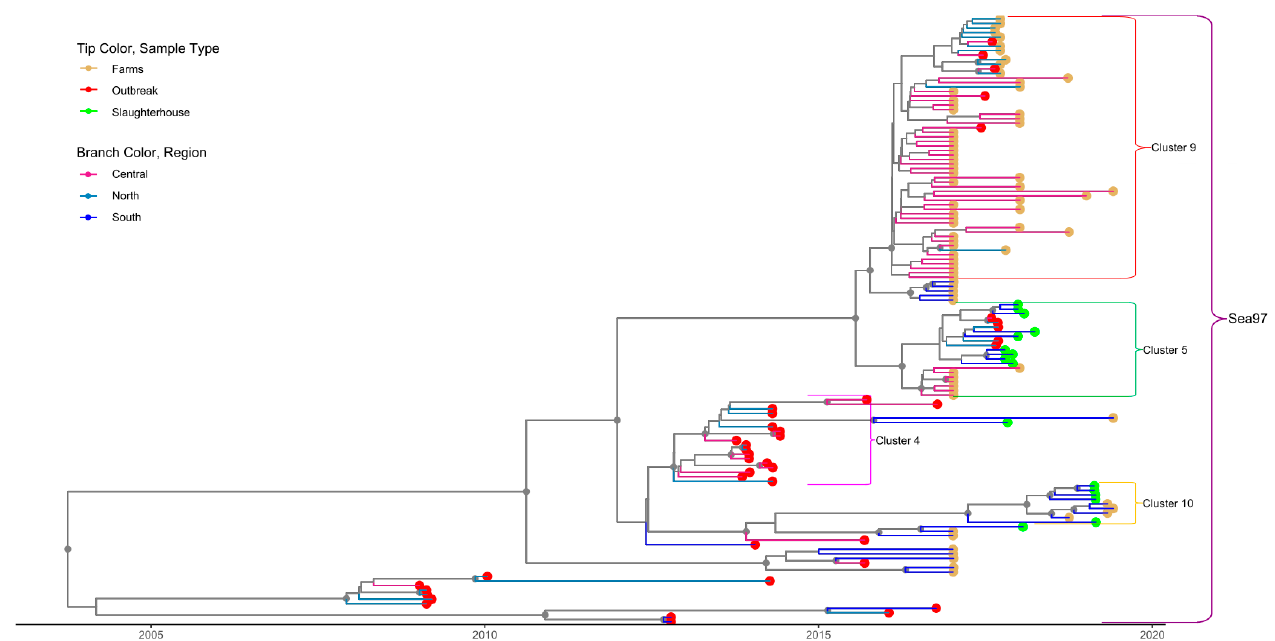
Figure 4. Time-scaled phylogeny for serotype A sequences isolated in Vietnam. All isolates belonged to the SEA-97 lineage. Tip color indicates the source type of data (slaughterhouse, farm and outbreak). Different branch colors show the region of the country where sequences were isolated. Small brackets identify the clusters; only clusters with >10 sequences are labelled. The large brackets identify the lineage to which each cluster belongs. Gray circles indicate well-supported clades (posterior probabilities >0.70.